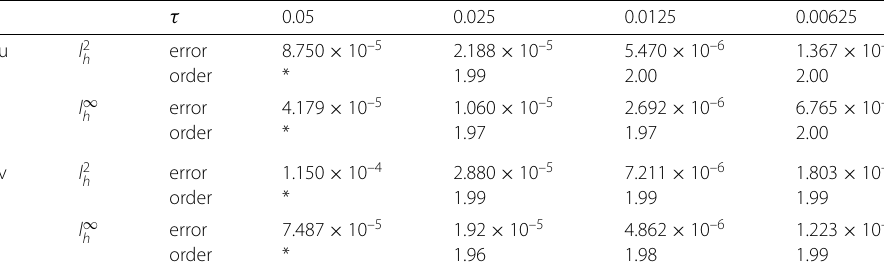
Table 1 Errors and orders in time for J = 1024, t = 1